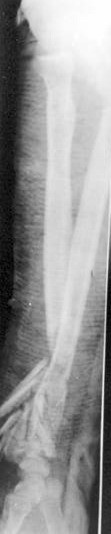
Lateral radiographs of his left forearm and wrist revealed the describing injury.